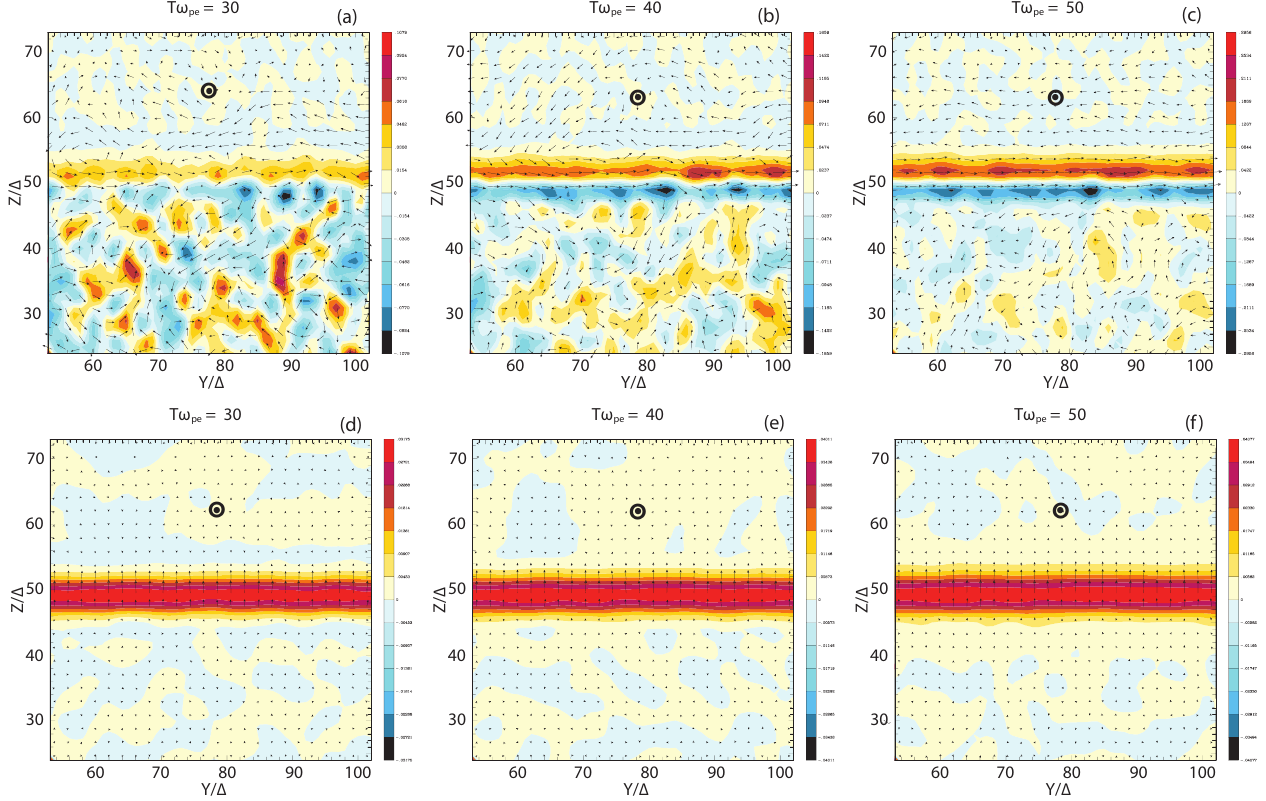
Fig. 3. The time evolution of current filaments ( J x ) and electric field ( E z ) in the area denoted by the small box in Fig. 2a. KKHI starts to grow at (a) t = 30 ω − 1 pe and current filaments become large but have not yet merged by (c) t = 50 ω − 1 pe . The maximum current density (simulation units) is (a) ± 0 . 108 at t = 30 ω − 1 pe , (b) ± 0 . 166 at t = 40 ω − 1 pe , and (c) ± 0 . 296 at t = 50 ω − 1 pe . The arrows show the magnetic field ( B y ,B z ) (the length of the arrows are not scaled to the strength of the magnetic fields). Panels (d) , (e) , and (f) show the time evolution of the electric field ( E z ) in the same area as the current filaments. The rather uniform electric field grows even at t = 30 ω − 1 pe . The maximum values of E z change with time (d) ± 0.032, (e) ± 0.040, and (f) ± 0.040. As seen from green lines in Fig. 4a, electric fields achieve a maximum at t = 45 ω − 1 pe and subsequently decrease.